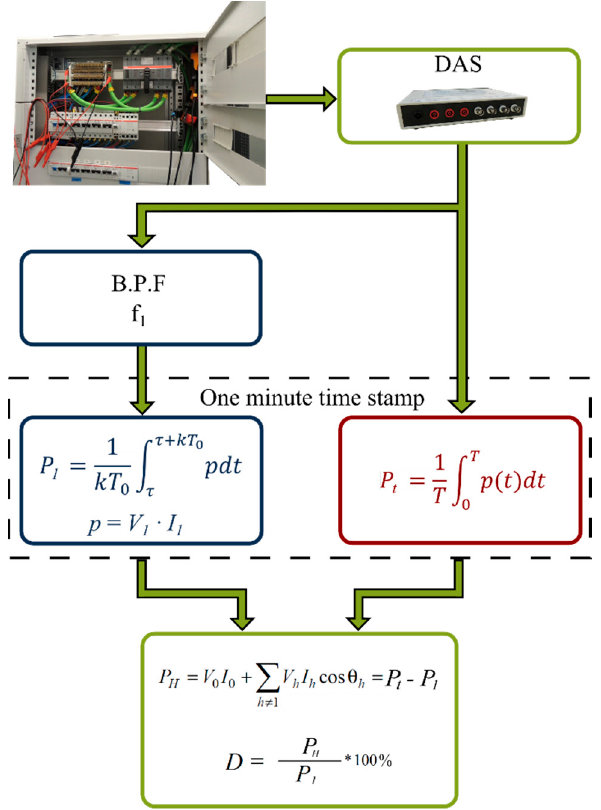
Figure 2. Flow diagram of the proposed methodology.